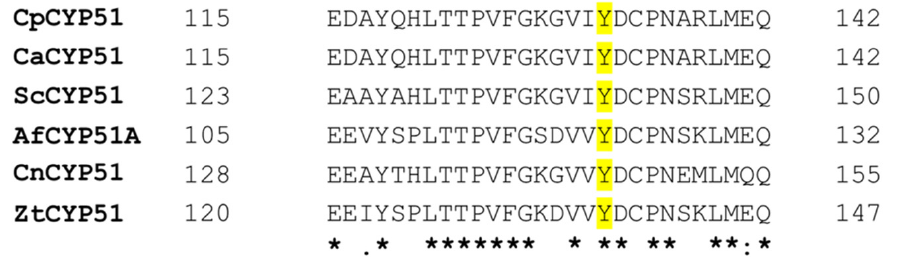
Figure 1. Primary sequence alignment of several fungal pathogens in the region of Y132 CpCYP51 using ClustalW. C. albicans CYP51 (CaCYP51), S. cerevisiae CYP51 (ScCYP51), A. fumigatus CYP51A (AfCYP51A), C. neoformans CYP51 (CnCYP51) and Z. tritici CYP51 (ZtCYP51). The tyrosine residue (Y), equivalent to Y132 in CpCYP51, is highlighted in yellow. An asterisk denotes conserved residues, a colon indicates conservative substitutions and a full stop marks semi-conservative substitu- tions.